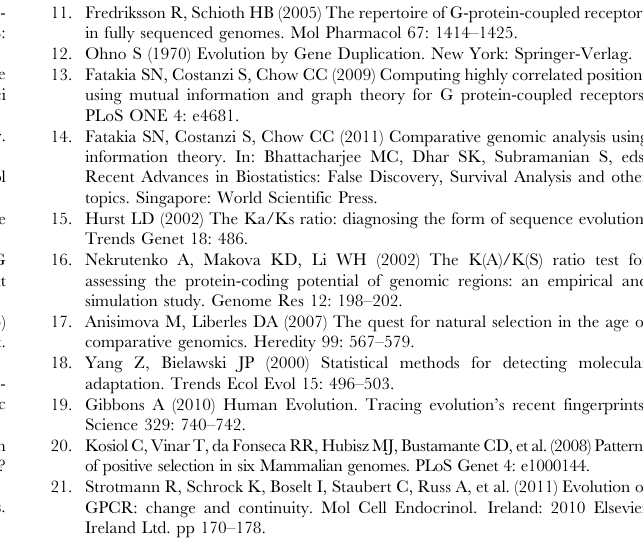
Figure S4 Average Shannon entropy vs. average selec- tion pressure for key positions across subgroups. Average scores from Figure S3 are plotted along the Y axis. Average evolutionary selection pressure from Figure 1 is represented using a logarithmic scale on the X axis. Subgroups not labeled ‘‘N’’ from Tables 1, 2, 3 and 4 (having pair-wise max( d N ) , 1) are represented here. (TIFF) Figure S5 Similarity scores for key positions across GPCR subgroups. Similarity scores ( , BLO_80 key . ) in sub- group MSA defined by Karlin and Brocchieri, as in Reference 67, (described in Materials and Methods) generated using BLO- SUM80 matrix. (TIFF) Figure S6 Average similarity score , BLO_80 key . vs. average selection pressure for key positions across subgroups. Average scores from Figure S5 are plotted along the Y axis. Average evolutionary selection pressure from Figure 1 is represented using a logarithmic scale on the X axis. Subgroups not labeled ‘‘N’’ from Tables 1, 2, 3 and 4 (having pair-wise max( d N ) , 1) are represented here. (TIFF) Figure S7 Inverse protdist distance measure ( ,2 log 10 D key . ) for key positions across GPCR sub- groups. Plot showing the logarithm of inverse protdist distance (D) at key positions from GPCR subgroups. (TIFF) Figure S8 Average inverse protdist distance vs. average selection pressure for key positions across subgroups. The Y-axis represents ,2 log 10 D key . from Figure S7. Average evolutionary selection pressure is represented using a logarithmic scale on the X axis. Subgroups not labeled ‘‘N’’ from Tables 1, 2, 3 and 4 (having pair-wise max( d N ) , 1) are represented here. (TIFF) Table S1 Tenable PAML models representing molecu- lar evolution of 7TMs of class A non-olfactory human GPCR subgroups. PAML’s tenable models that represent molecular evolution of their 7TMs are illustrated across GPCR subgroups. Results from two ‘‘random sites models’’ M2a vs.M1a